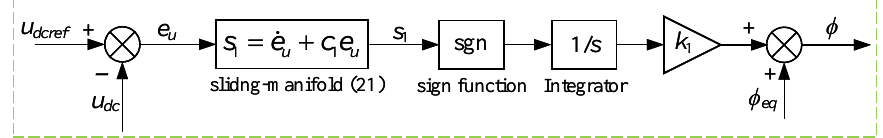
Figure 2. Calculation flowchart of the full-order sliding-mode control